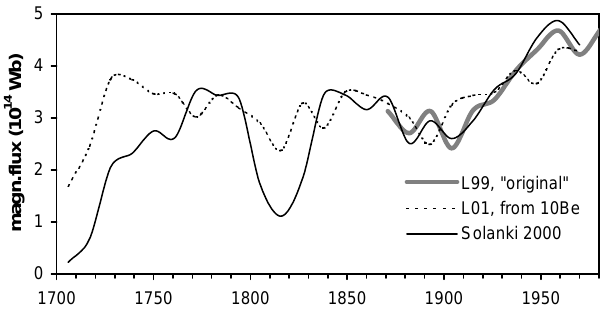
Fig. 4. 11-year running mean solar magnetic fluxes: the “original” coronal source flux F s by Lockwood et al. (1999), F s reconstructed by L01 from 10 Be series, and the open solar magnetic flux F o re- constructed by Solanki et al.